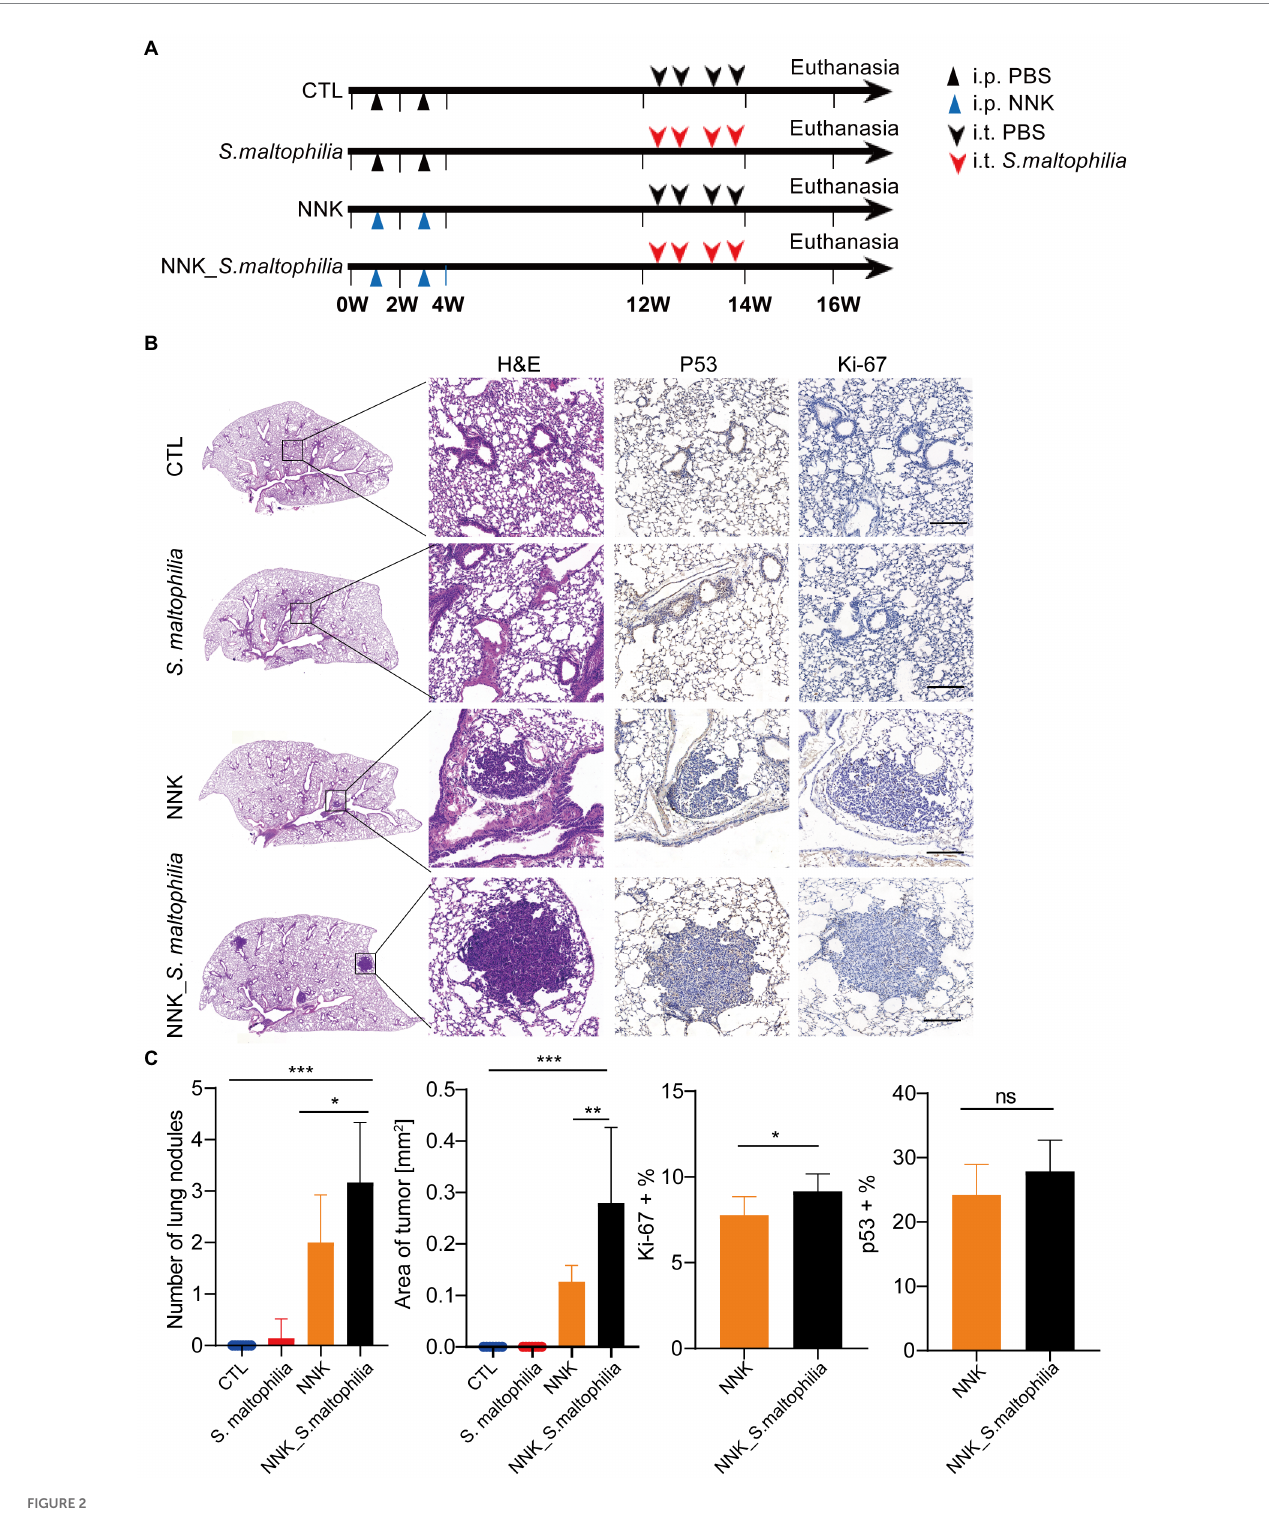
FIGURE 2 Stenotrophomonas maltophilia promotes lung cancer progression in mice. (A) Study design and diagram. (B) H&E staining, IHC staining of p53 and Ki-67 in lung tissues. Scale bar = 100 μ M. (C) The quantification of nodules on the lung surface, primary tumor area (mm 2 ), and percentage of p53 and Ki-67 positive area. Results are expressed as the mean ± SEM. * p < 0.05, ** p < 0.01, *** p < 0.001 by Student’s t -test. For each experiment, n = 5–8 mice/group. ns, no